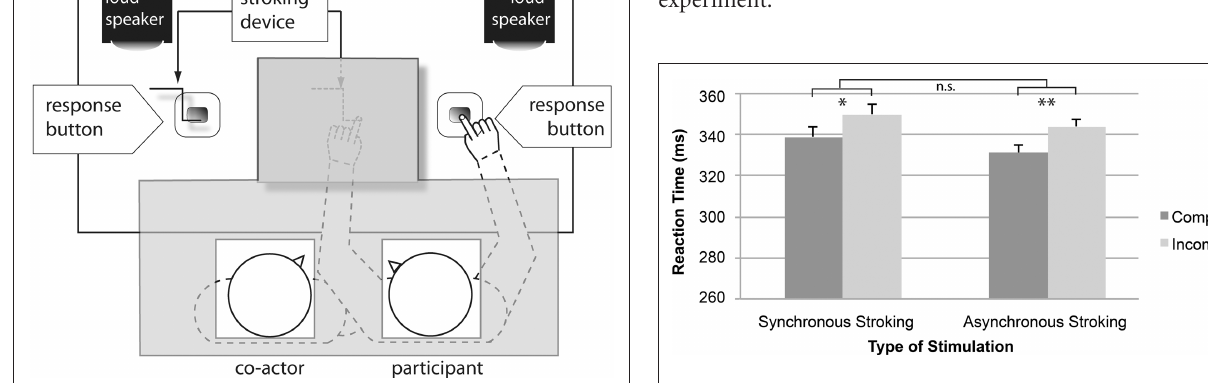
Figure 4 | experimental setting in experiment 2. Gray shaded areas indicate areas obscured from view.